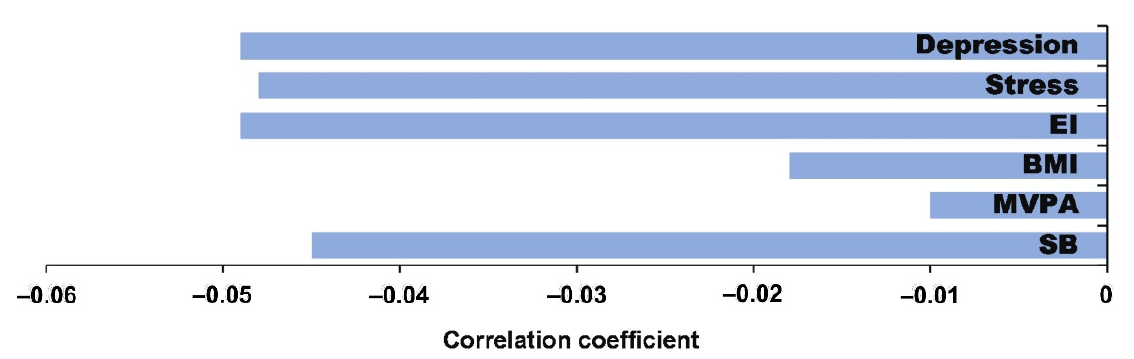
Figure 8. Correlation coefficient between CRT (LT) and depression, stress, EI, BMI, MVPA, and SB.